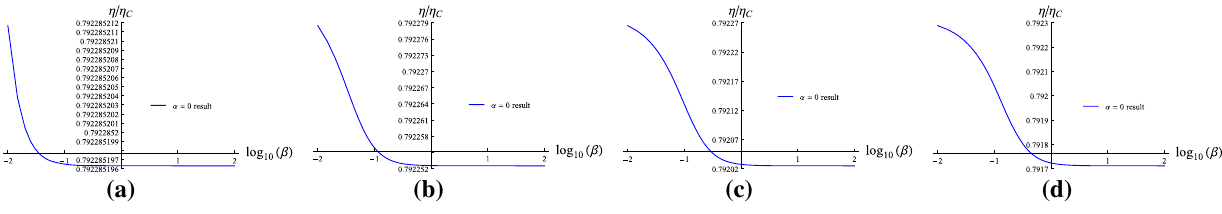
Fig. 3 Effect of q on efficiency, a for q = 2, b for q = 25, c for q = 70 and d for q = 100, when other parameters (see the caption of Fig. 2 for parameter values) are fixed